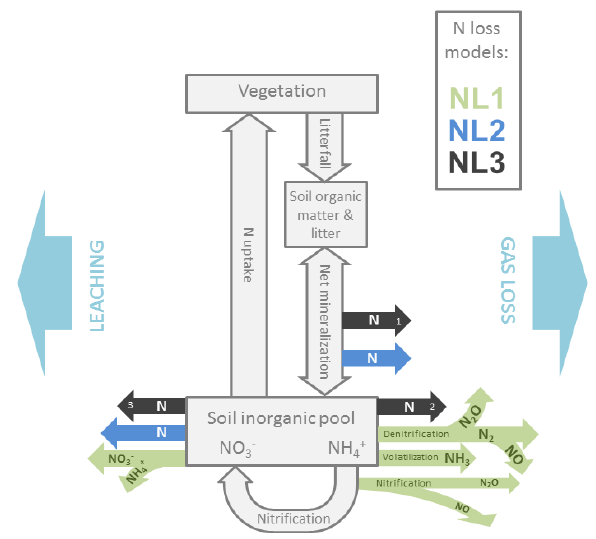
Figure 1. Simplified representation of the modelled internal nitro- gen (N) cycle and the three employed N loss algorithms. External input fluxes from deposition, biological fixation, and weathering are not shown. Grey boxes and arrows indicate N pools (vegetation, soil organic matter, litter, soil inorganic pools) and fluxes (litterfall, net mineralization, nitrification, uptake). Coloured arrows indicate N loss fluxes as they are calculated from different pool sizes and flux magnitudes according to the three algorithms NL1, NL2, and NL3. Numbers in the black arrows indicate the sequential nature of the NL3 approach. N: generic nitrogen species; N 2 : dinitrogen; NO: nitric oxide; N 2 O: nitrous oxide; NH 3 : ammonia; NO − trate; NH + : ammonium. Arrow orientation to the left/right indicates 4 leaching/gaseous